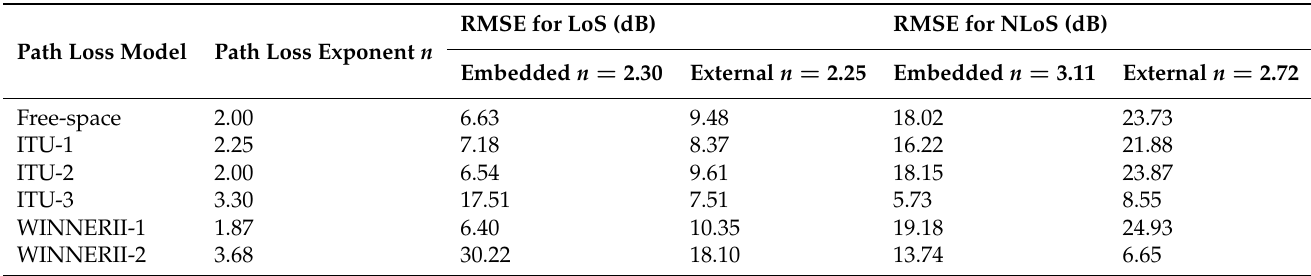
Table 8. Comparison of the IQRF Models with Empirical Models for LoS and NLoS